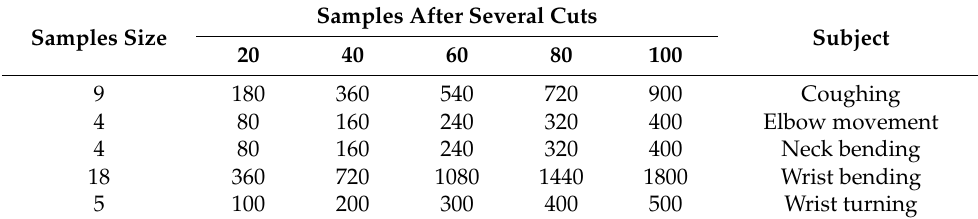
Table 4. Detail information about the dataset after several